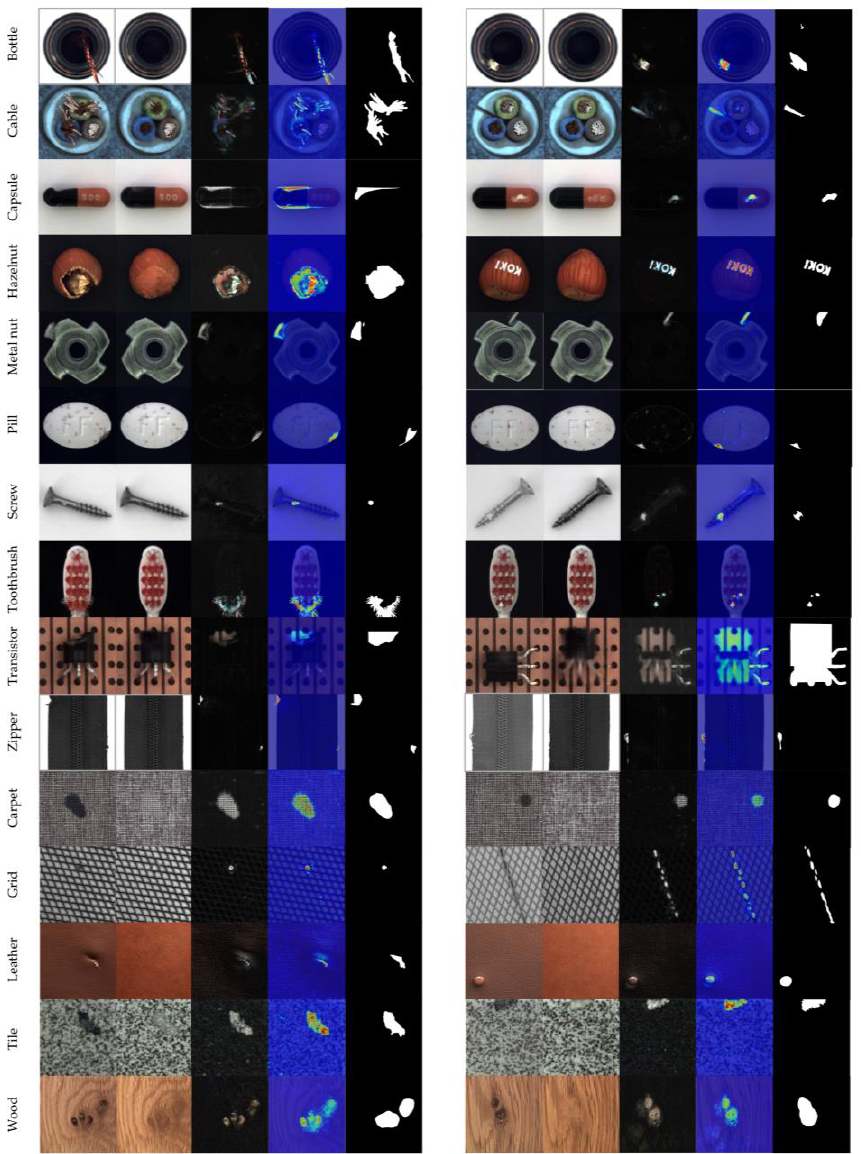
Figure 8. The detection results of all of the categories. From left to right: anomaly images, recon- structed images, residual image, heat map, and ground truth.